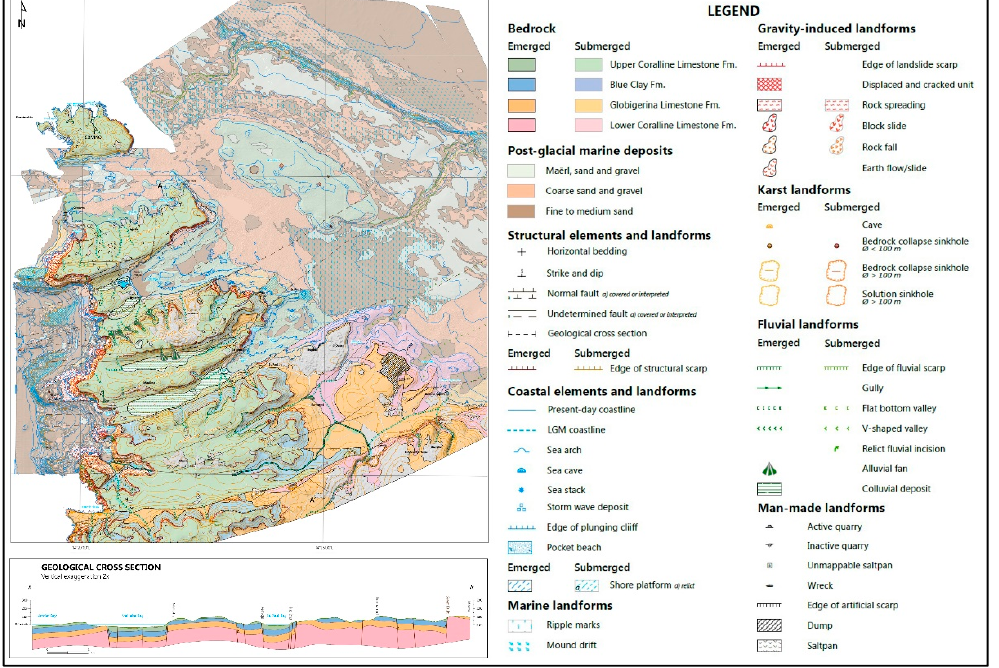
Figure 3. Sketch of the “Integrated geomorphological map of emerged and submerged areas of northern Malta and Comino (central Mediterranean Sea)” at 1:25,000 scale and related legend (modified after Prampolini et al. [6]).